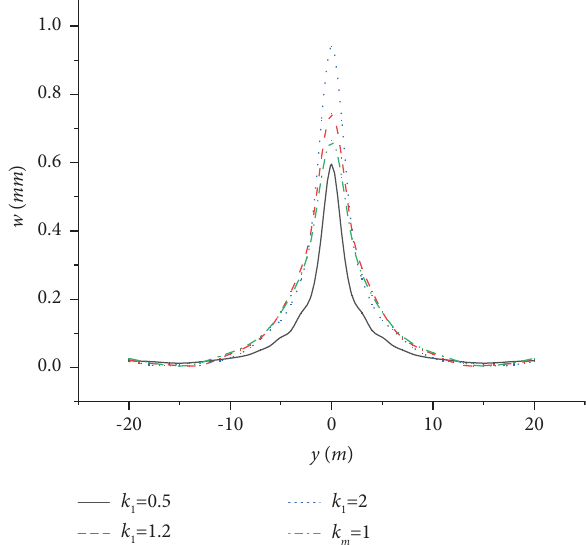
Figure 5: Plate deformation curves in y- direction due to E